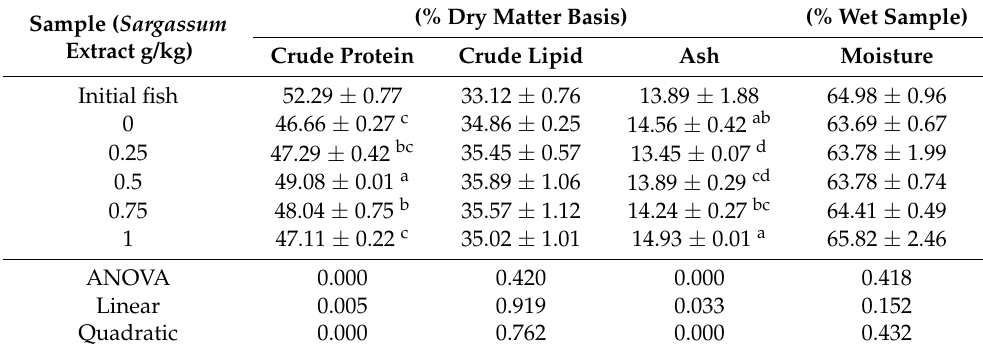
Table 4. Whole-body composition of spotted scat fed the experimental diets for 8 weeks.